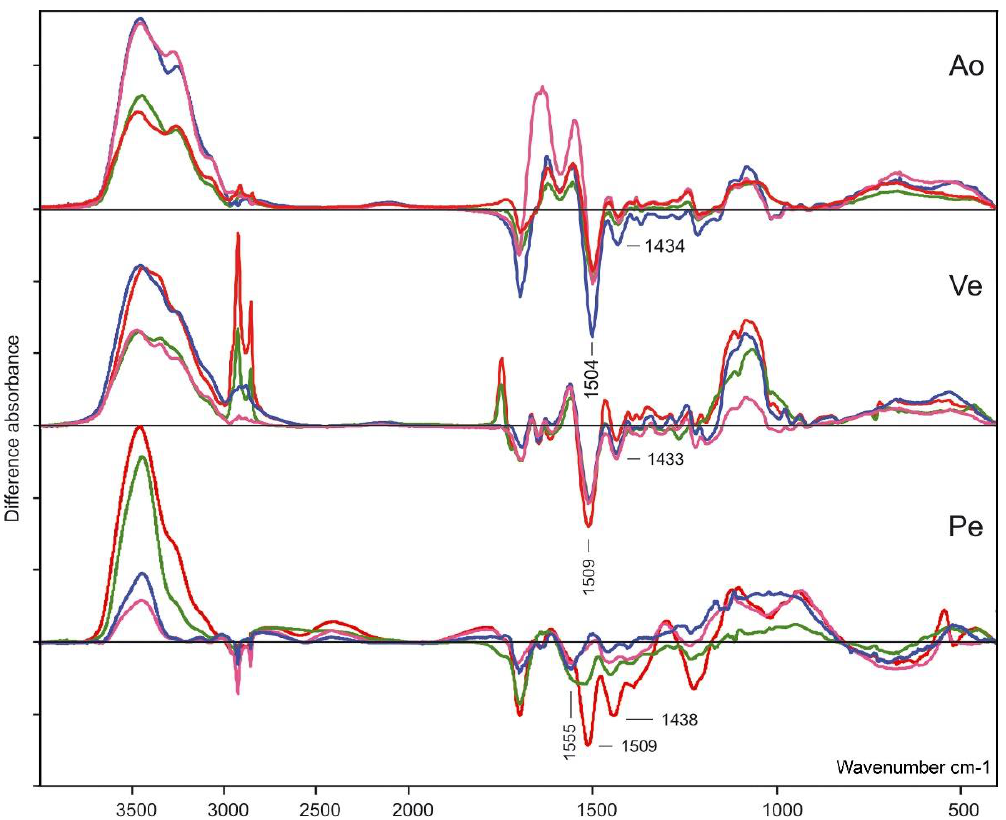
Figure 4. Difference FTIR spectra of the cross-linked biomaterials treated with PAM and CEABA (GA + PAM—red line, GA + CEABA—green line, DE + PAM—blue line, DE + CEABA—pink line).